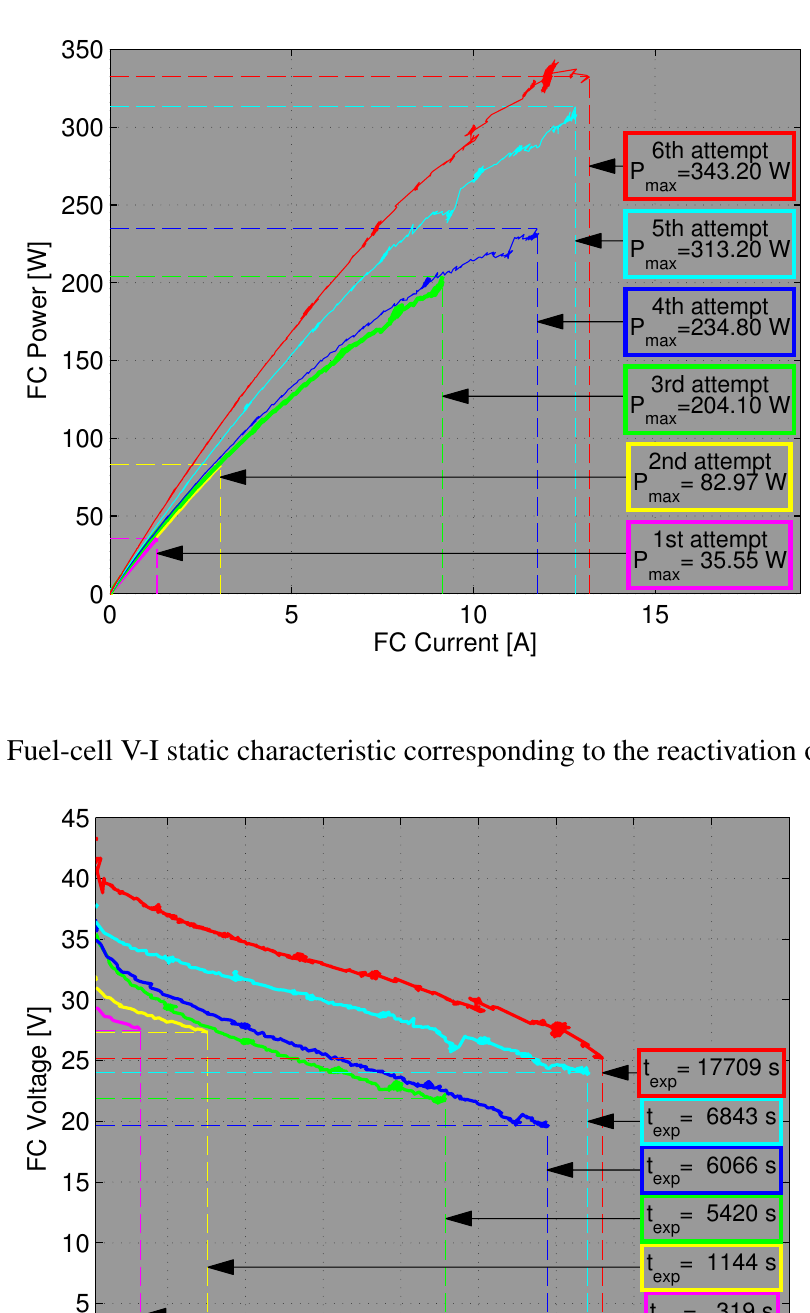
Figure 12. Fuel-cell power-current characteristic obtained following the reactivation process of flowchart Figure 8. Six reactivation cycles were required to recover a maximum power level of 340 W.